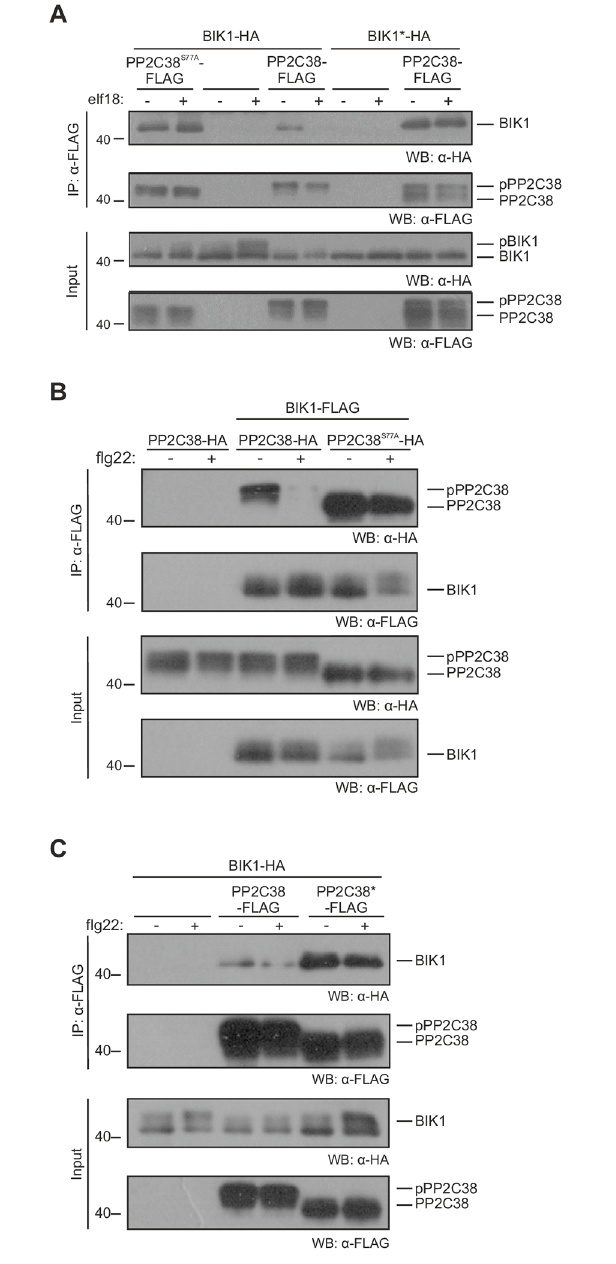
Fig 6. Phosphorylation and catalytic activity are required for PP2C38-BIK1 dissociation. (A-C) Dissociation of PP2C38-BIK1 complex after PAMP perception. Arabidopsis Col-0 protoplasts were co- transfected with PP2C38-FLAG/HA or indicated variants together with BIK1/BIK1 * -HA/FLAG, and treated (+) or not (-) with 1 μ M elf18/flg22 for 30 min. PP2C38-BIK1 complexes were analysed by immunoblotting following α -FLAG immunoprecipitation. Each experiment repeated at least three times with similar